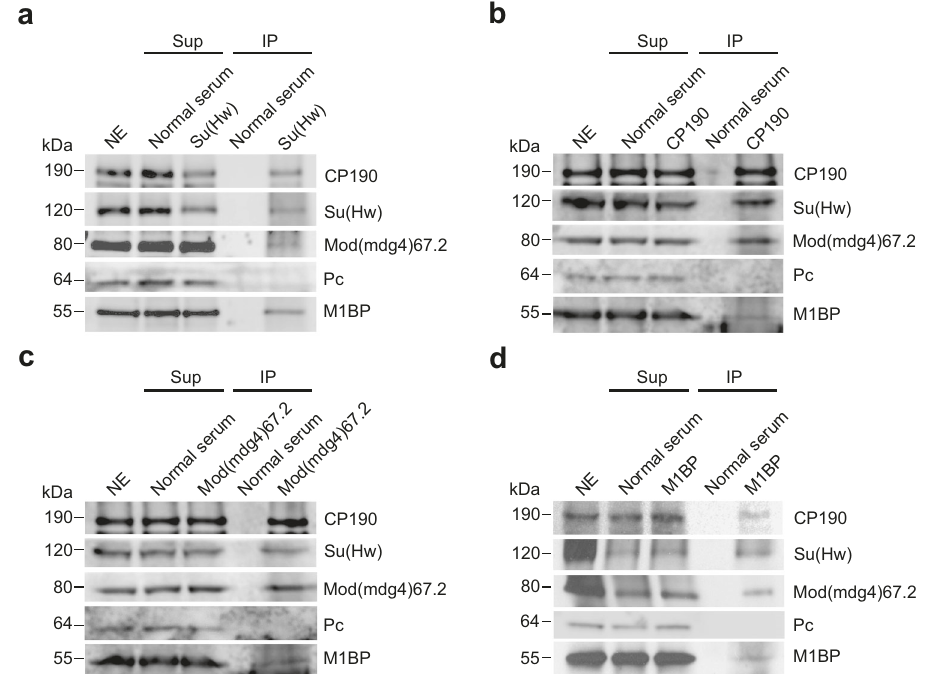
Fig. 1 Co-immunoprecipitation of core gypsy components with M1BP. a Nuclear extracts (NE) from embryos aged 0 – 24 h were immunoprecipitated with either normal guinea pig serum or guinea pig anti-Su(Hw) antibody. Unbound supernatant (Sup) and bound (IP) fractions are shown. Polycomb (Pc) is shown as a negative control. In all, 10% of NE is loaded in the gel. We calculated that 5.2% of total CP190, 7.2% of Su(Hw), 1.9% of Mod(mdg4)67.2, and 5.3% of M1BP were immunoprecipitated with anti-Su(Hw) antibody. b Immunoprecipitation of M1BP with normal guinea pig serum or guinea pig anti- CP190 is shown. Overall, 12% of total CP190, 7.0% of Su(Hw), 8.2% of Mod(mdg4)67.2, and 3.8% of M1BP were immunoprecipitated with anti-CP190 antibody. c Immunoprecipitation of M1BP with normal rabbit serum or rabbit anti-Mod(mdg4)67.2 is shown. Overall, 11% of total CP190, 8.5% of Su(Hw), 10% of Mod(mdg4)67.2, and 3.0% of M1BP were immunoprecipitated with anti-Mod(mdg4)67.2 antibody. d Immunoprecipitation of M1BP with normal rabbit serum or rabbit anti-M1BP is shown. Overall, 3.8% of total CP190, 2.6% of Su(Hw), 1.4% of Mod(mdg4)67.2, and 3.7% of M1BP were immunoprecipitated with anti-M1BP antibody. Samples from the same experiment were run on different gels for proteins with similar molecular weights. All western blotting experiments were performed with at least two independent biological replicates for each antibody, and a single experiment is